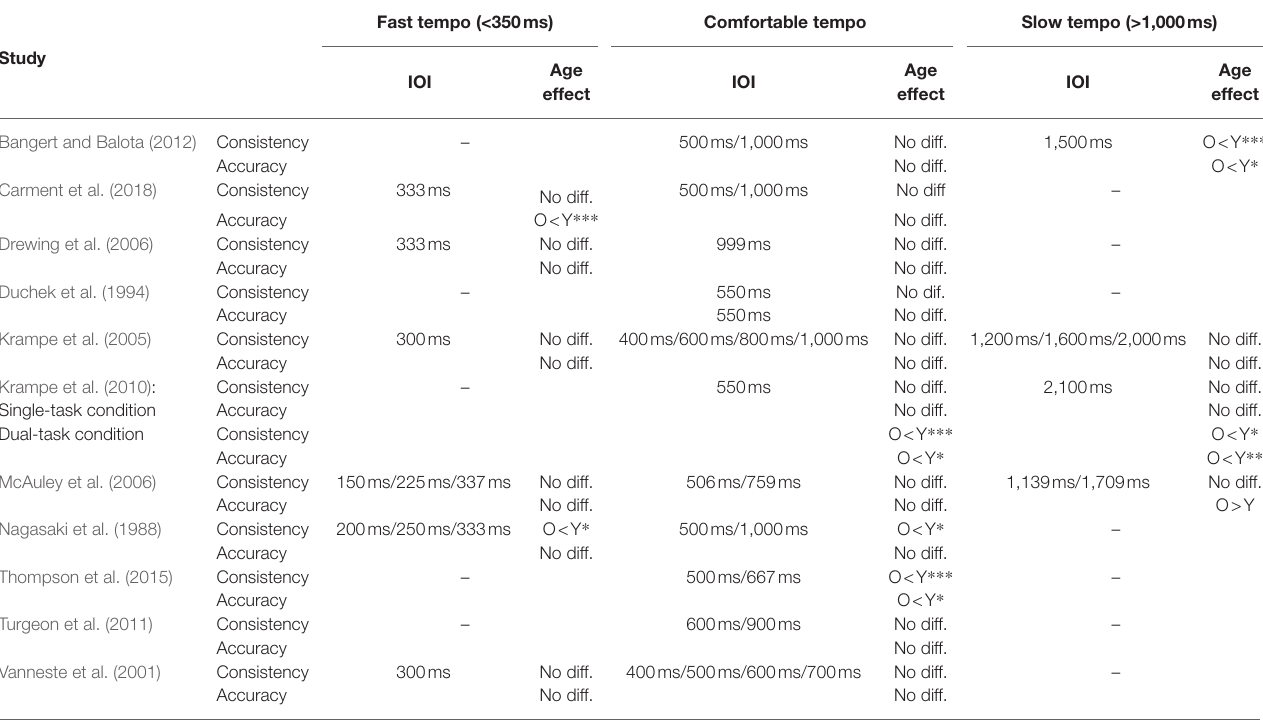
TABLE 2 | Studies investigating paced tapping in different age